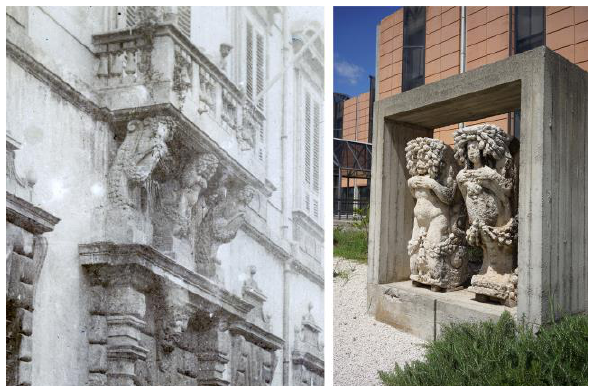
Figure 4 . The corbels from Palazzo